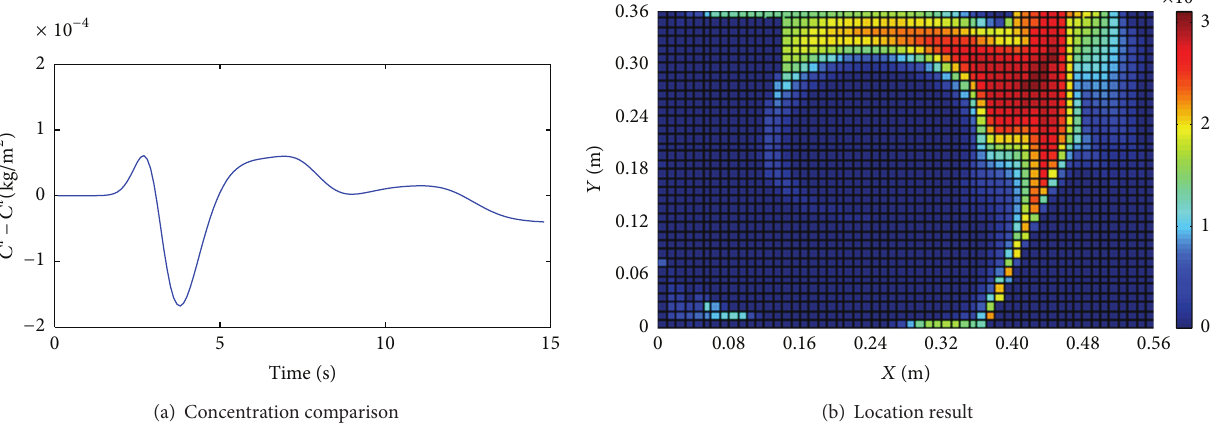
Figure 4: Results for Case 2 ( V